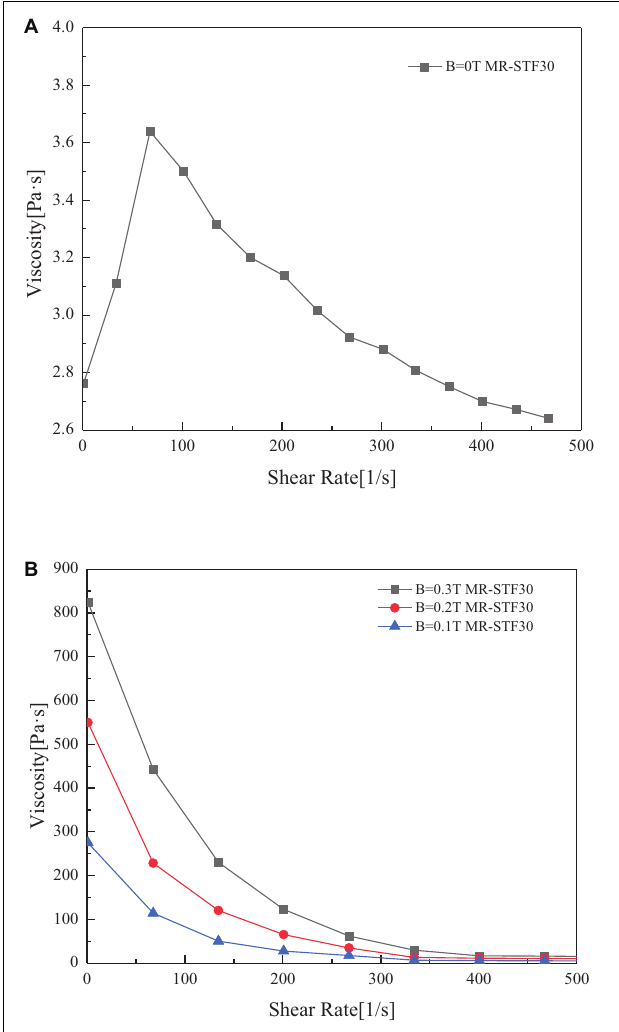
FIGURE 1 | Measured curves between viscosity and shear rate of the MR-STF (A) without and (B) with magnetic